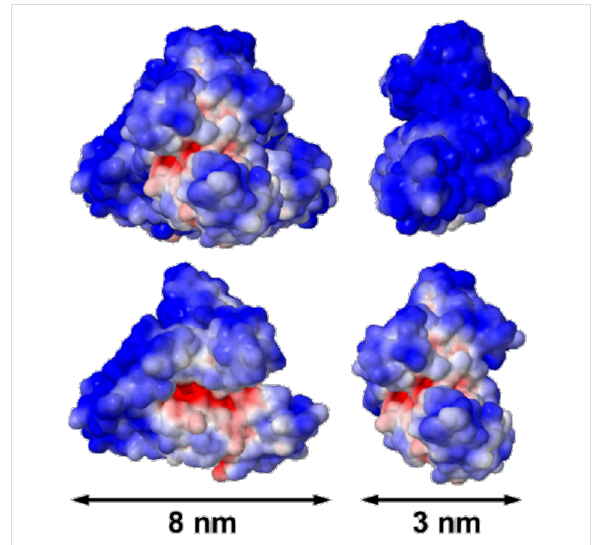
Figure 3: Human serum albumin (HSA, PDB code: 1UOR) repre- sented as space-filling models, colored to indicate surface electrosta- tics at pH 7.4 (blue, negative potential; red, positive potential; range from − 5 k B T / e to +5 k B T / e (calculated online at http://nbcr- 222.ucsd.edu/pdb2pqr/49 [158,159]). Reprinted with permission from [4]. Copyright 2014 American Chemical